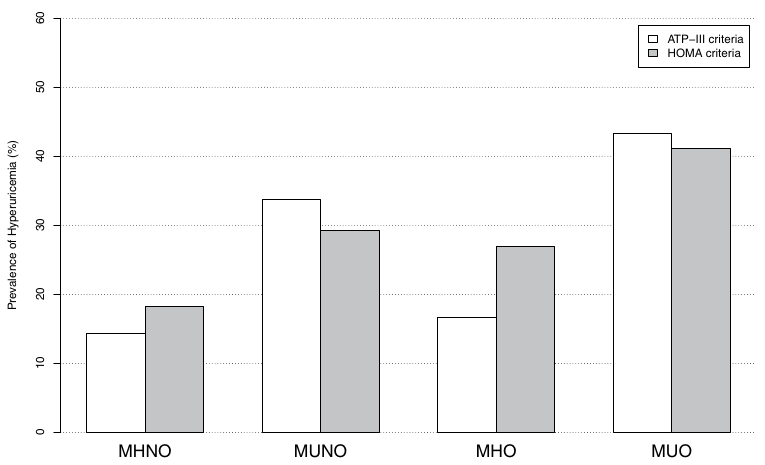
Figure 1. Prevalence of hyperuricemia according to metabolic health and obesity status (metabolic obesity phenotypes). The metabolic health status was defined by ATP-III and HOMA criteria, respectively; the obesity status was defined by body mass index. Abbreviations : ATP-III, the Adult Treatment Panel-III; HOMA, homeostasis model assessment of insulin resistance; MHNO, metabolically healthy non-obese; MUNO, metabolically unhealthy non-obese; MHO, metabolically healthy obese; and MUO, metabolically unhealthy obese.